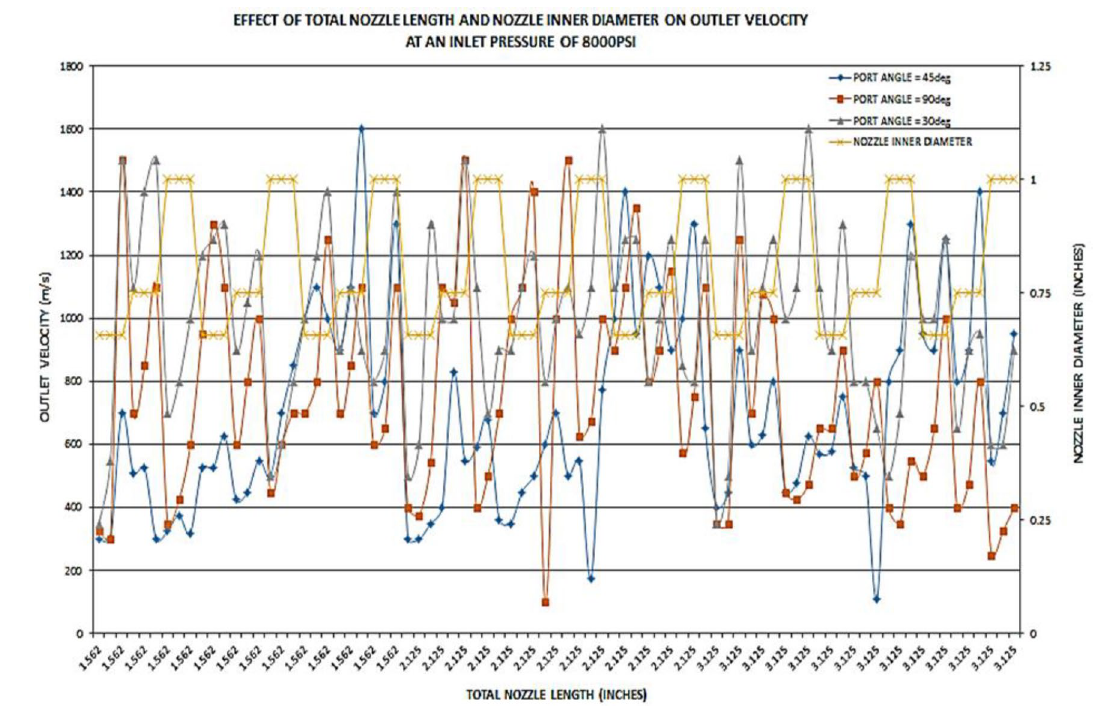
Table 9 Effects of total nozzle length, nozzle id and port angle on outlet velocity